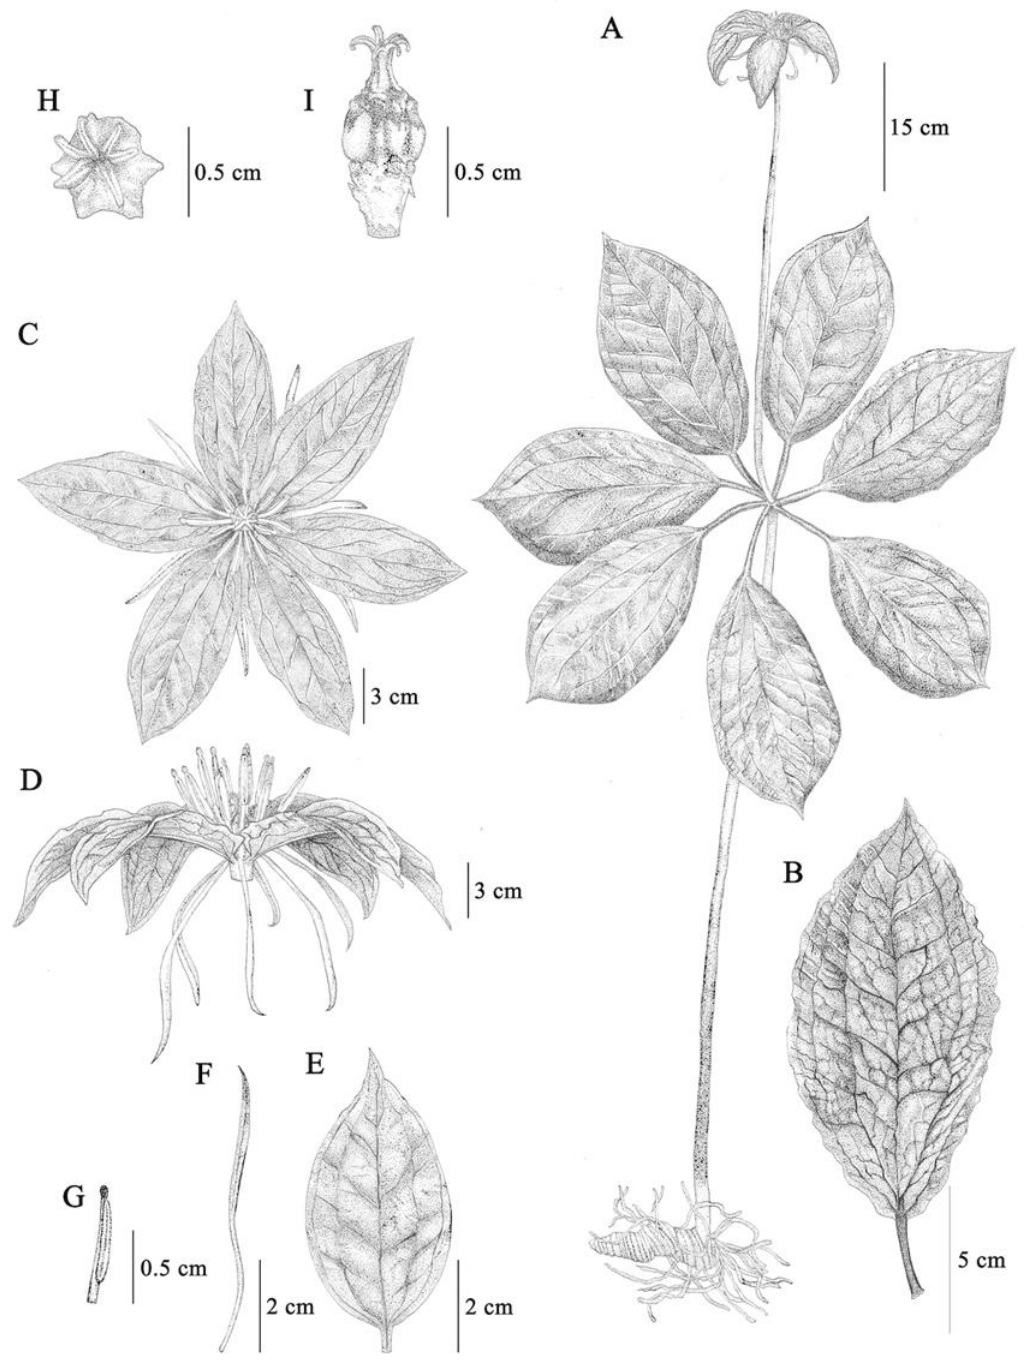
Figure 3. Paris siamensis Ruchis. ( A ) Plant, ( B ) Leaf, ( C ) Flower (front view), ( D ) Flower (lateral view), ( E ) Sepal, ( F ) Petal, ( G ) Stamen, ( H ) Pistil (front view), ( I ) Pistil (lateral view). (Drawn by Jeerapach Monthanom).